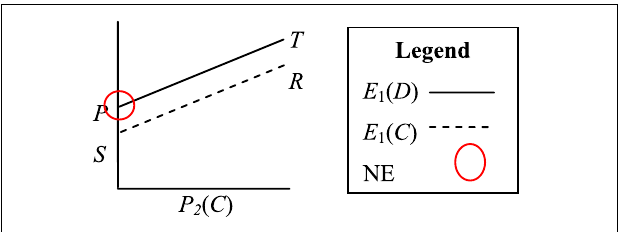
FIGURE 1 | Visualization of the Prisoner’s Dilemma payoff structure T > R > P > S . The Nash Equilibrium (NE) is